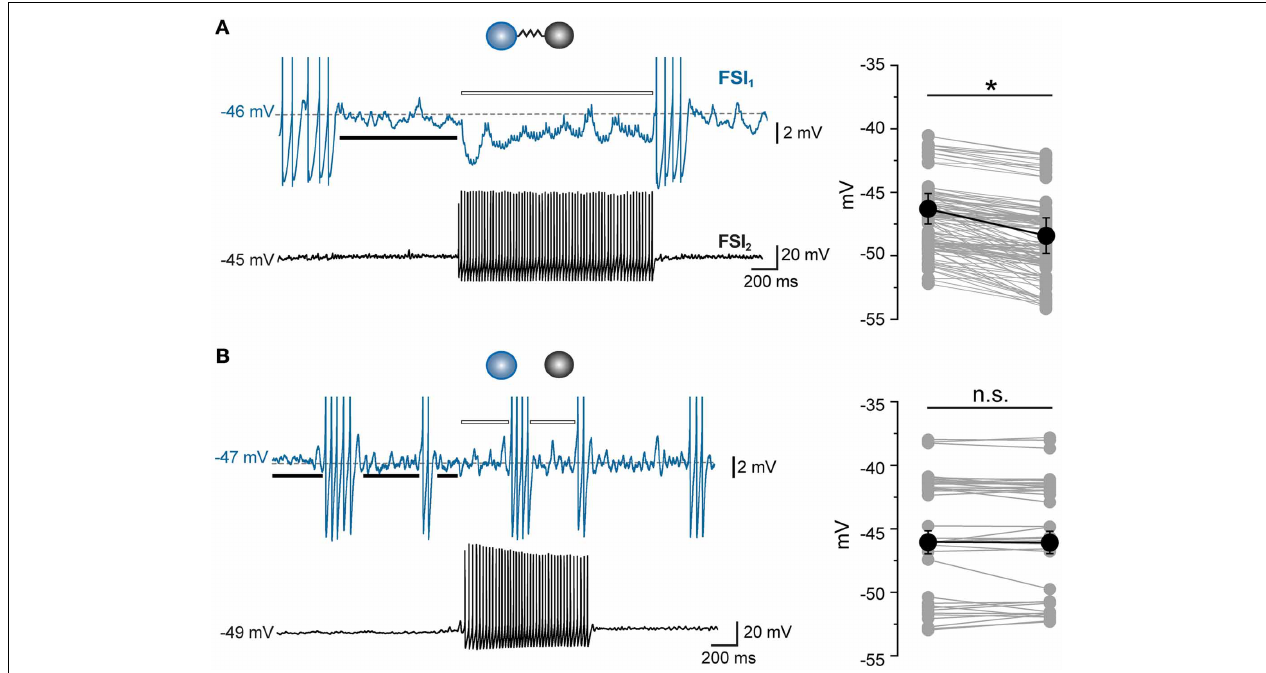
FIGURE 7 | Gap junctions prevent postsynaptic firing by inducing V m hyperpolarization at near-threshold levels. (A) Example of a GJ-only connected pair in which FSI 1 displayed an array of subthreshold spikelets in response to a train of AP occurring in FSI 2 during DC injection in both cells (380 and 405pA, respectively, 20s). The average V m value of FSI 1 during the spikelet barrage was measured throughout the duration of FSI 2 burst (indicated by the white bar) and compared to the average V m value before the burst onset (black bar). Right, summary of average V m